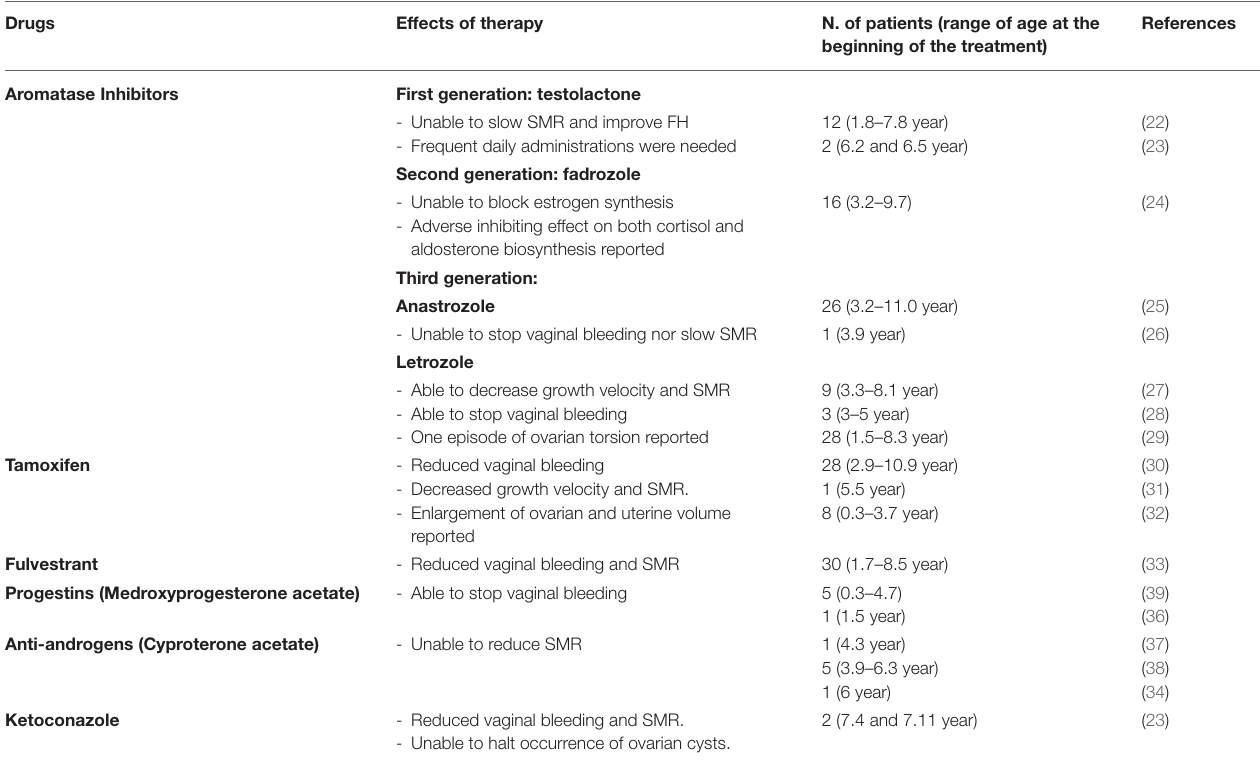
TABLE 1 | Available data on pharmacologic management of PPP in girls with MAS. Drugs Effects of therapy N. of patients (range of age at the